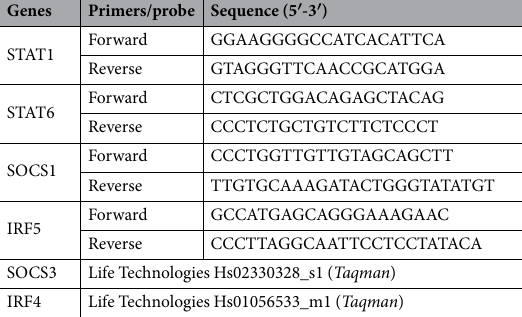
Table 2. Primer sequences used in rRT-PCR